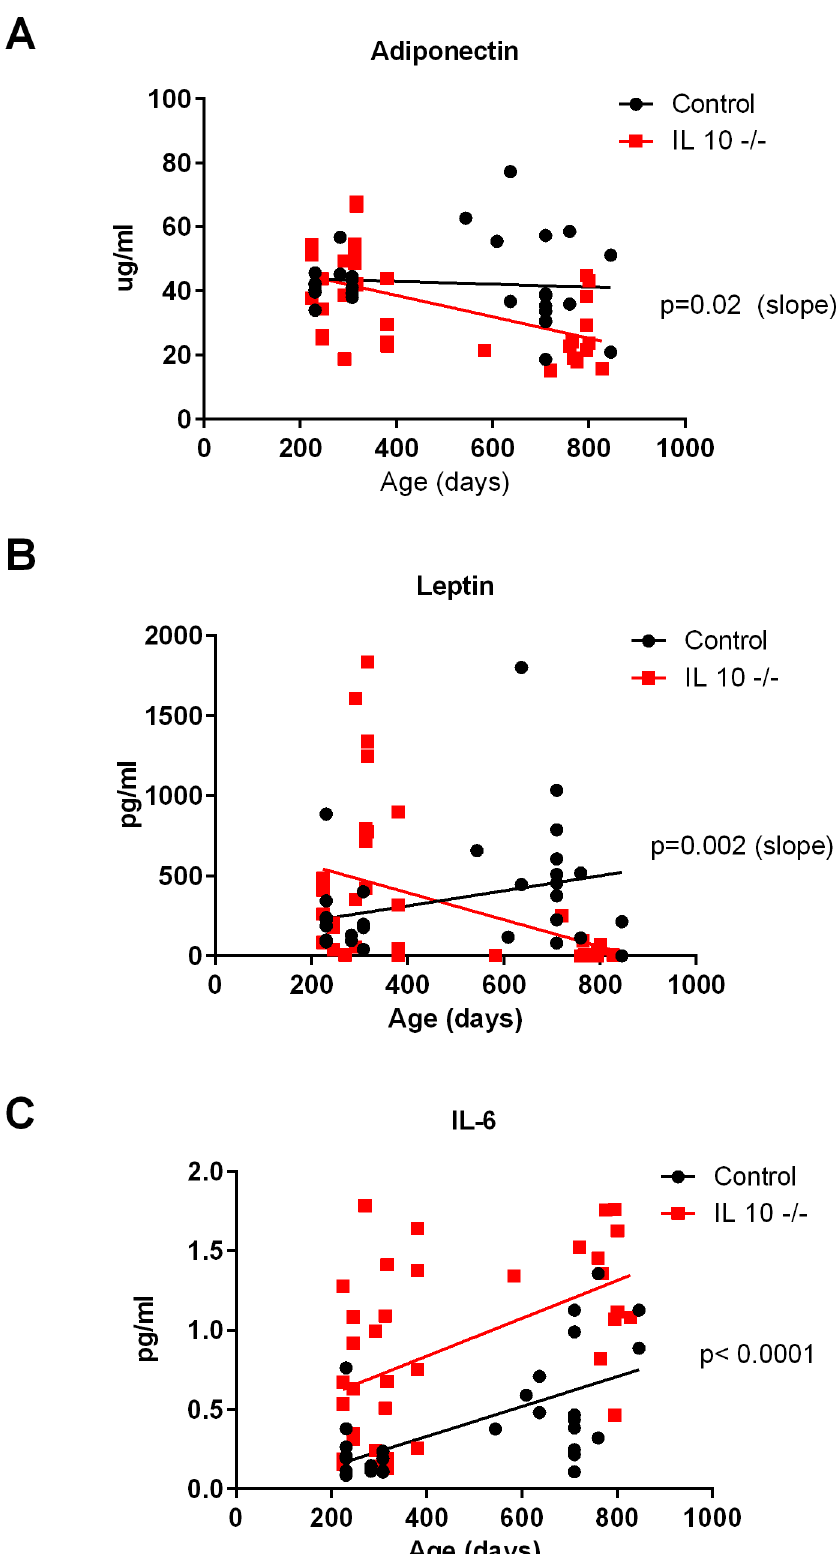
Fig 4. Plasma adipokine measurements across age groups at time of sacrifice. Adiponectin(Fig 4A), leptin (Fig 4B) and IL-6 (Fig 4C). https://doi.org/10.1371/journal.pone.0186811.g004 PLOS ONE | https://doi.org/10.1371/journal.pone.0186811 December21,